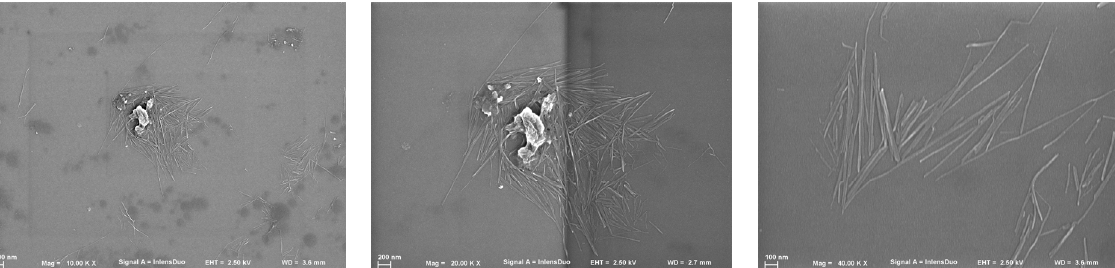
Figure 3. Scanning electronic microscopy (SEM) images of cellulose fibers extracted from the tunic of Styela clava after sulfuric acid treatment. Table 1. Characteristics of the cellulose nanocrystals from different sources compared to this work.